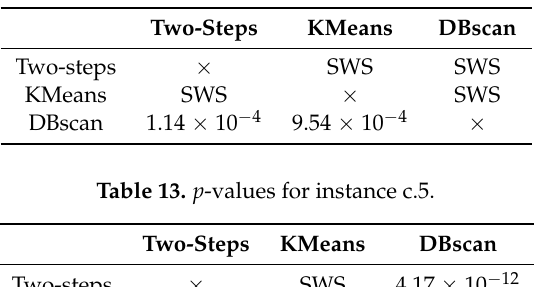
Table 12. p -values for instance b.5.